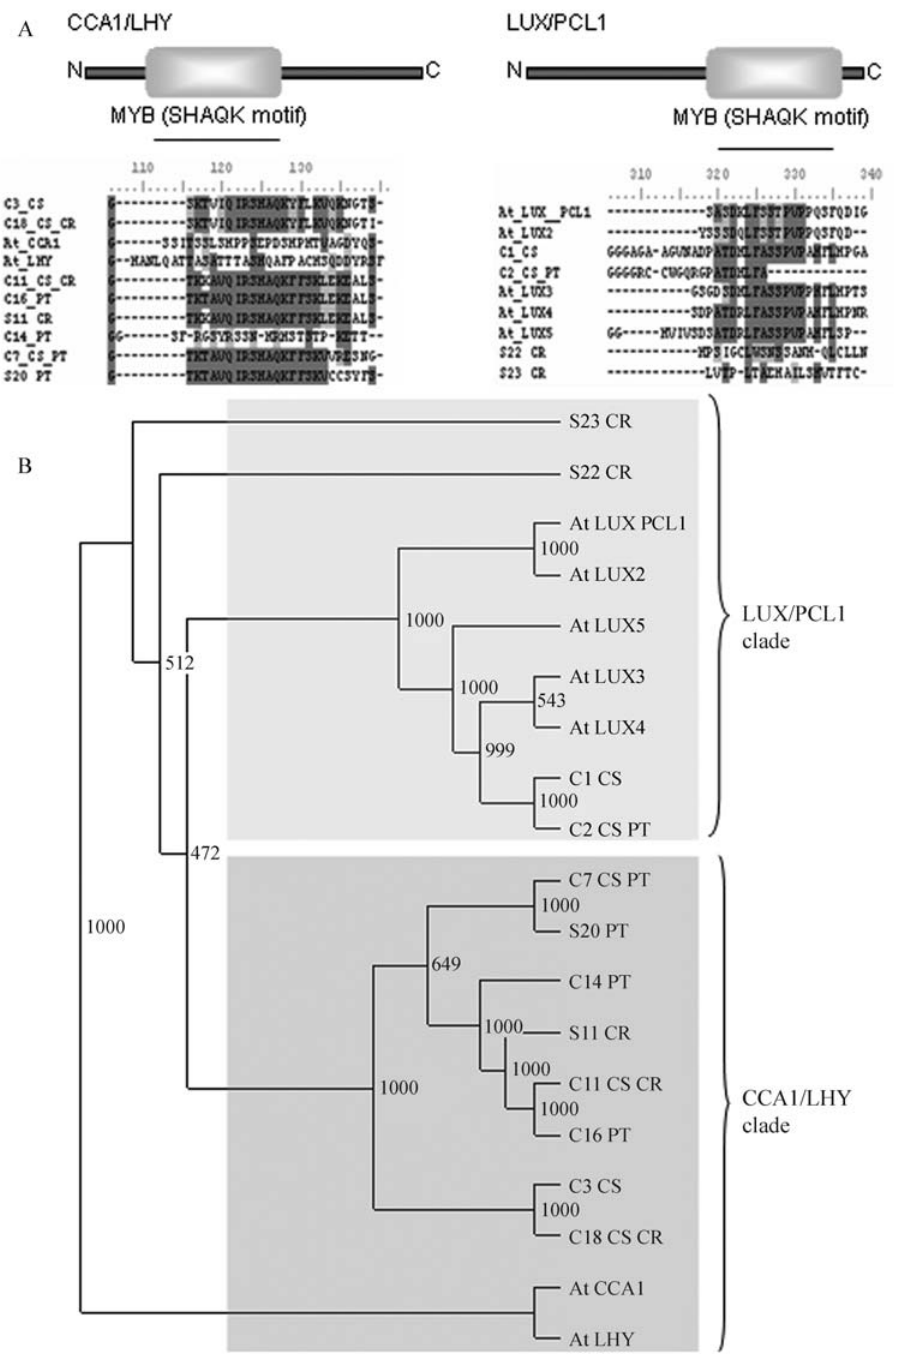
Figure2 - MYB-typetranscriptionfactorsinvolvedinthecircadianclockincitrusand A.thaliana . A. SchematicrepresentationofCCA1/LHYandLUX protein domains and MYB domain alignment in citrus and A. thaliana . B. Phylogenic analysis of citrus and Arabidopsis CCA1/LHY and LUX protein families. Neighbor-joining tree for citrus deduced amino acid and Arabidopsis full length sequences were aligned with ClustalX. Bootstrap values are in- dicated above each branch. At, Arabidopsis thaliana ; C Number, contig number; CS, Citrus sinensis ; CR, Citrus reticulata ; PT, Poncirus trifoliata